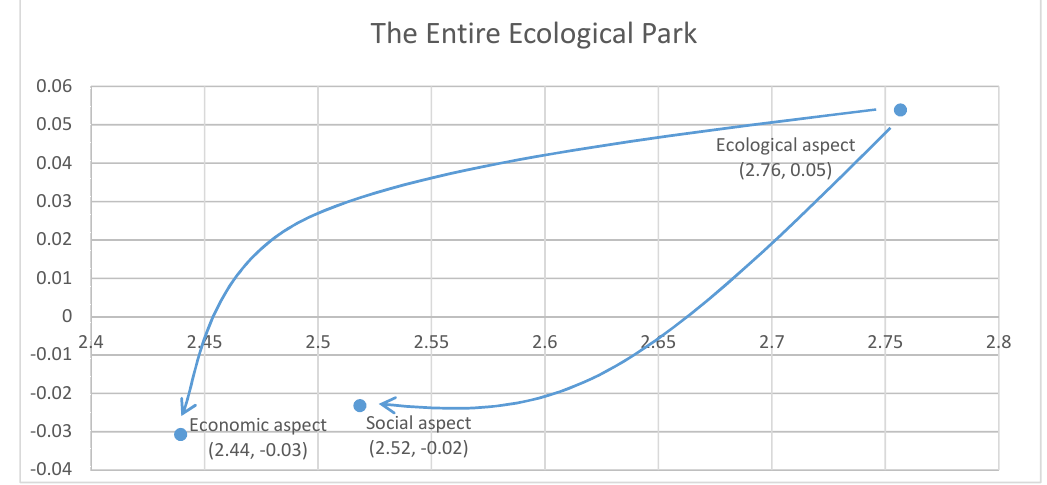
Figure 2. Scatter plot of the correlation (D + R) and causality (D − R) results for the economic, ecological, and social aspects.